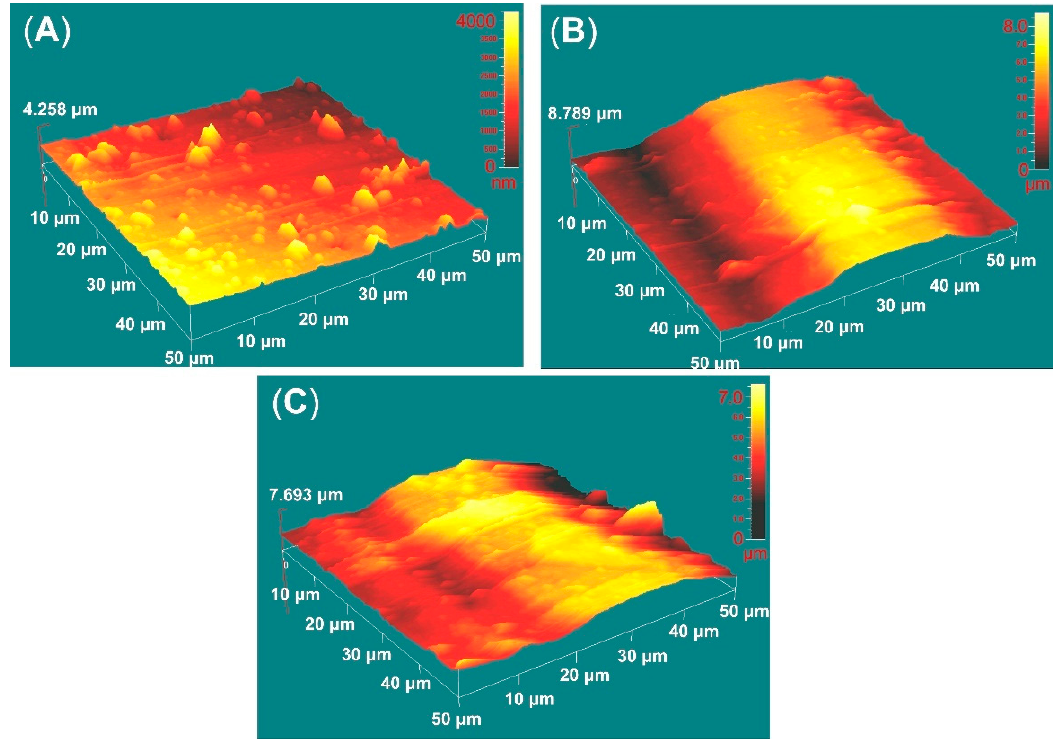
Figure 4. AFM deflection images of TiN/TiO 2 coatings deposited on the polished AR ( A ), AR500 ( B ), and AR850 ( C ) samples. Table 3. Statistical values of the surface roughness of TiN/TiO 2 coatings deposited on the polished AR and AR500 samples: S a —average surface roughness, S q —root mean square roughness, S sk — skewness, R pv —average peak-to-valley roughness.